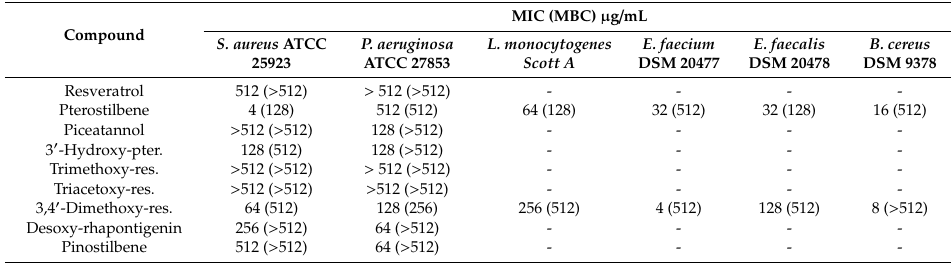
Table 2. MIC and minimum bactericidal concentration (MBC) values (in brackets) of stilbenoid monomers from Mattio et al. (2019) [36].